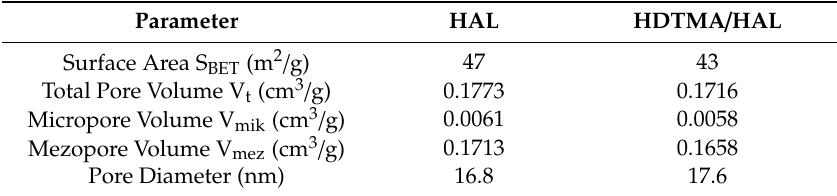
Figure 3. Adsorption and desorption isotherm for nitrogen for HAL and HDTMA/HAL adsorbents. Table 2. Surfaces properties of adsorbents determined from isotherms of nitrogen.